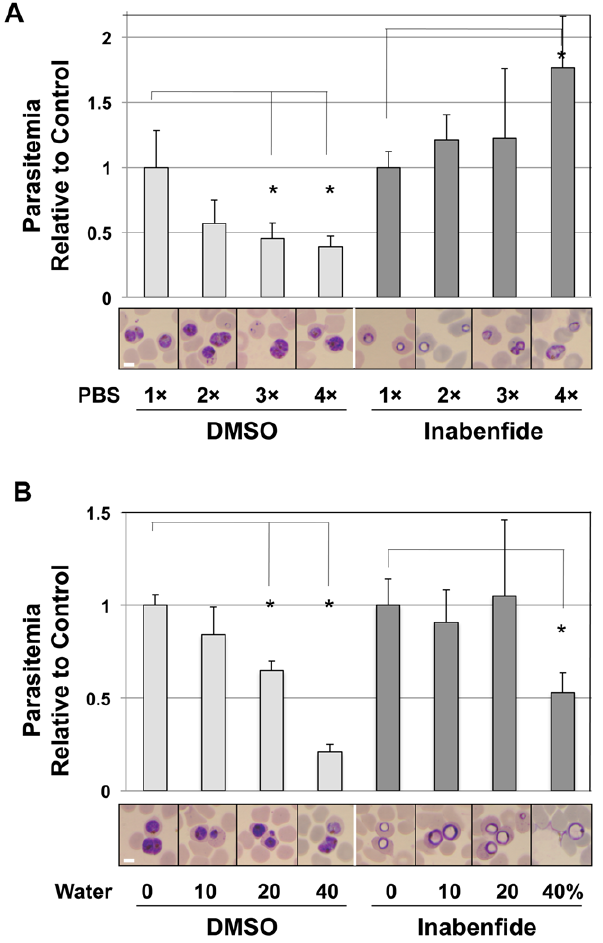
Figure 5. Effects of osmotic pressure to intraerythrocytic parasites treated with INA. (A) Effects of hyperosmotic stress in INA-treated parasites. P. falciparum cultures treated with 50 m M INA were observed in various dilution ratios of PBS for 8 h. Parasitemia was determined by Giemsa-stained thin blood smears. Student’s t -test: *P . 0.005. Values are means 6 SD of n=6 in two independent experiments. Data were normalized relative to control cultures (1 6 PBS) in DMSO- and INA-treated samples, respectively. Representative parasite morphologies are shown for each treatment. Scale bar, 3 m m. (B) Effects of hyposmotic stress, experimentally induced by the addition of water to the culture medium of P. falciparum , after 8 h of 50 m M INA treatment. N=6 smears each in two independent experiments. doi:10.1371/journal.pone.0032246.g005 Figure S1 Concentration-response curve of INA. Each point represents the mean 6 standard deviations (SD) from three independent experiments, with each treatment duplicated twice. (TIF)